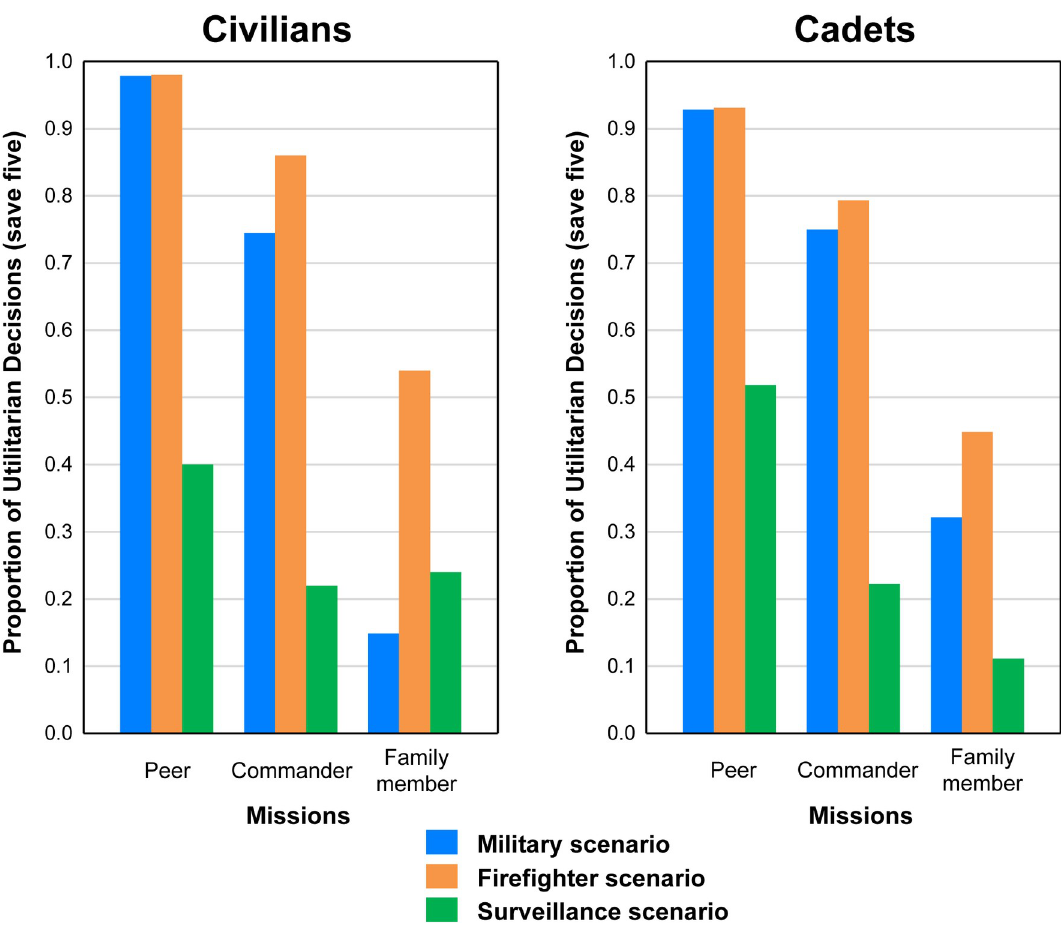
Fig 2. Decision patterns. Proportion of utilitarian decision in for Civilians (left side) and Cadets (right side).